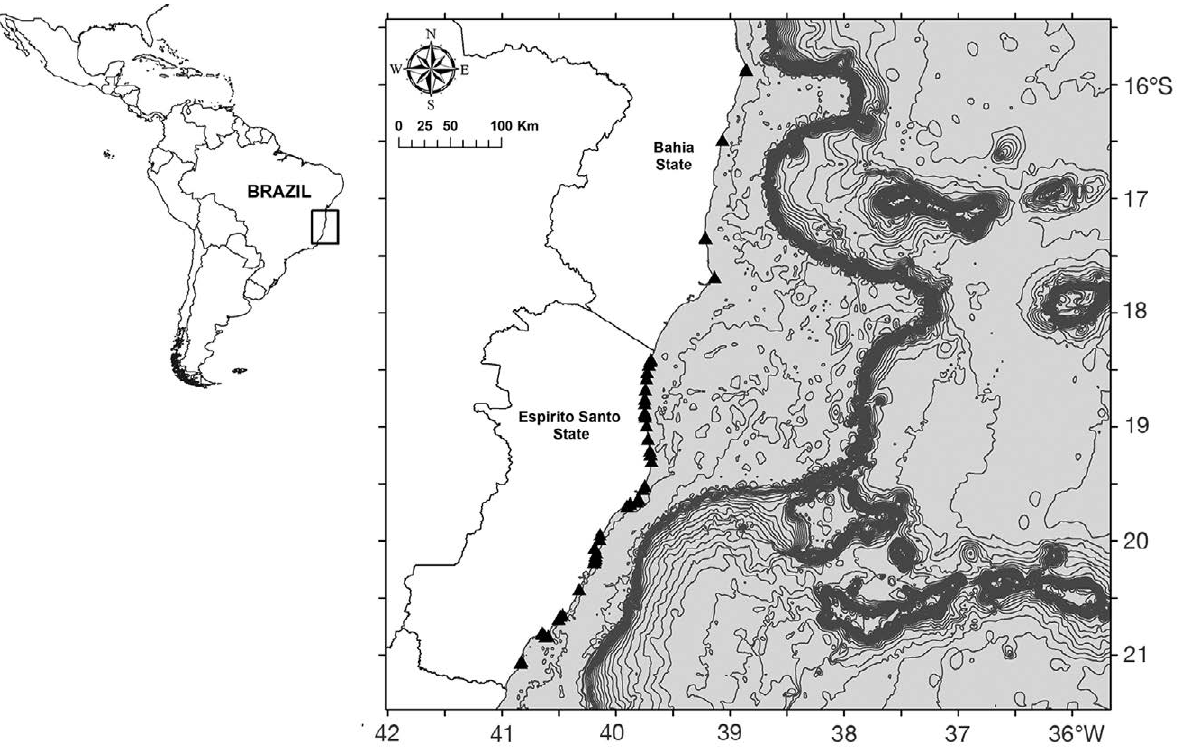
Fig. 1. – Study area shows sites in which stranded carcasses of Guiana dolphin (triangles) were found along a coastline ranging from the south- ern Bahia State to the southern Espirito Santo State, along the southeastern coast of Brazil. Collection acquired from June 2007 to April